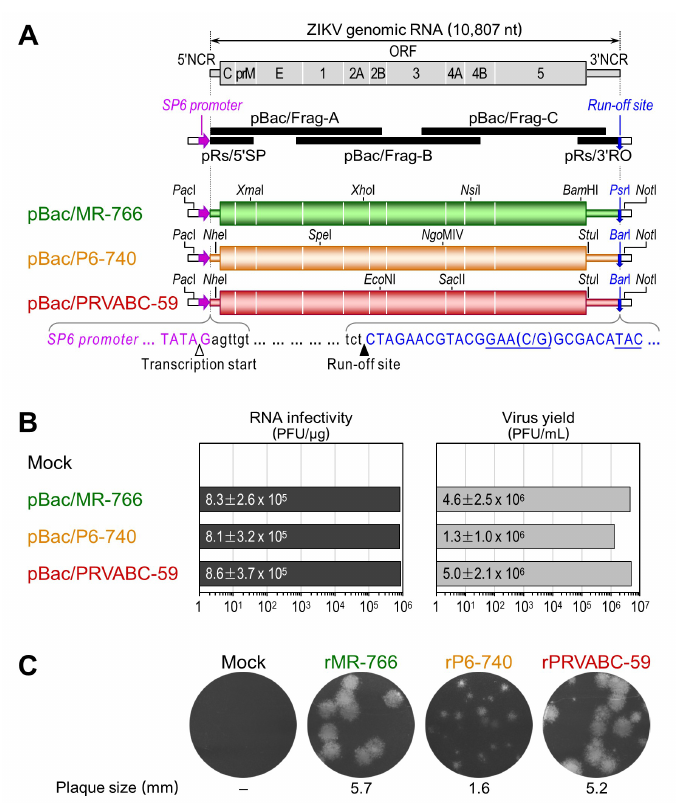
Figure 2. A trio of functional ZIKV cDNAs was created for the rescue of three molecularly cloned genetically divergent strains: rMR-766, rP6-740, and rPRVABC-59. ( A ) Construction of three full-length ZIKV cDNAs as BACs for MR-766, P6-740, and PRVABC-59. In all three cases, each genomic RNA (top panel) was first subcloned into five overlapping cDNAs (middle panel), which were then joined at four shared restriction sites as indicated to assemble its full-length cDNA without introducing any point mutations for cloning (bottom panel). Presented below the three full-length cDNAs are the sequences corresponding to the 5′ and 3′ termini conserved in all three ZIKVs (black lowercase), an SP6 promoter placed just upstream of the viral genome (magenta uppercase), and a run-off site positioned immediately downstream of the viral genome ( Psr I or Bar I, blue uppercase). Marked below the sequences are the transcription start (white arrowhead) and run-off (black arrowhead) sites. ( B ) Functionality of the three full-length ZIKV cDNAs. After linearization with Psr I or Bar I, as appropriate, each full-length cDNA was used as a template for in vitro transcription with SP6 RNA polymerase in the presence of the dinucleotide cap analog m 7 GpppA. Capped RNA transcripts were transfected into Vero cells to determine the number of infectious centers (plaques) counterstained with crystal violet at 5 days after transfection (RNA infectivity). At 36 h post-transfection, culture supernatants from RNA-transfected cells were harvested to estimate the level of virus production by plaque assays on Vero cells (Virus yield). Means and standard deviations from three independent experiments are shown. ( C ) Plaque morphology. The average plaque sizes were estimated by measuring 20 representative plaques.